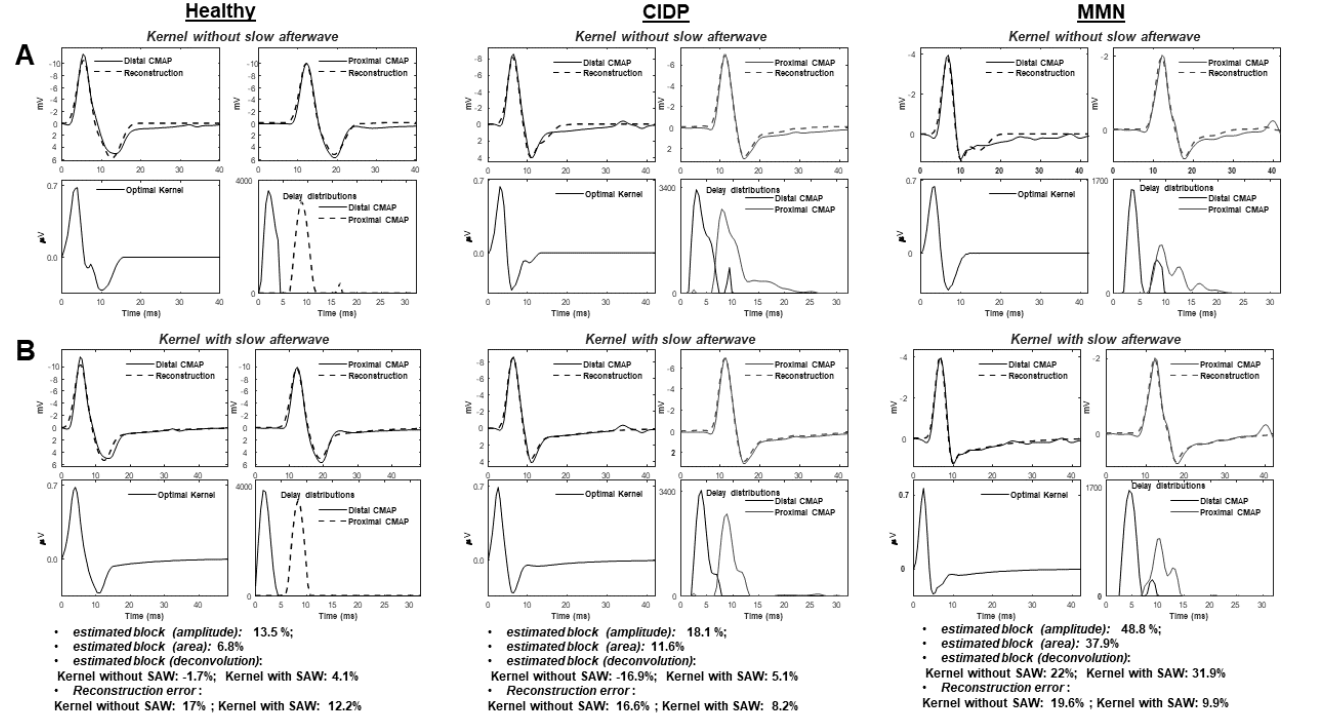
Figure 3. Comparison of deconvolution methods either excluding ( A ) or including ( B ) the SAW in estimating the kernel. Examples of data from healthy, CIDP and MMN subjects are considered. The estimation of CB is given in all cases, including also the approaches based on amplitude and